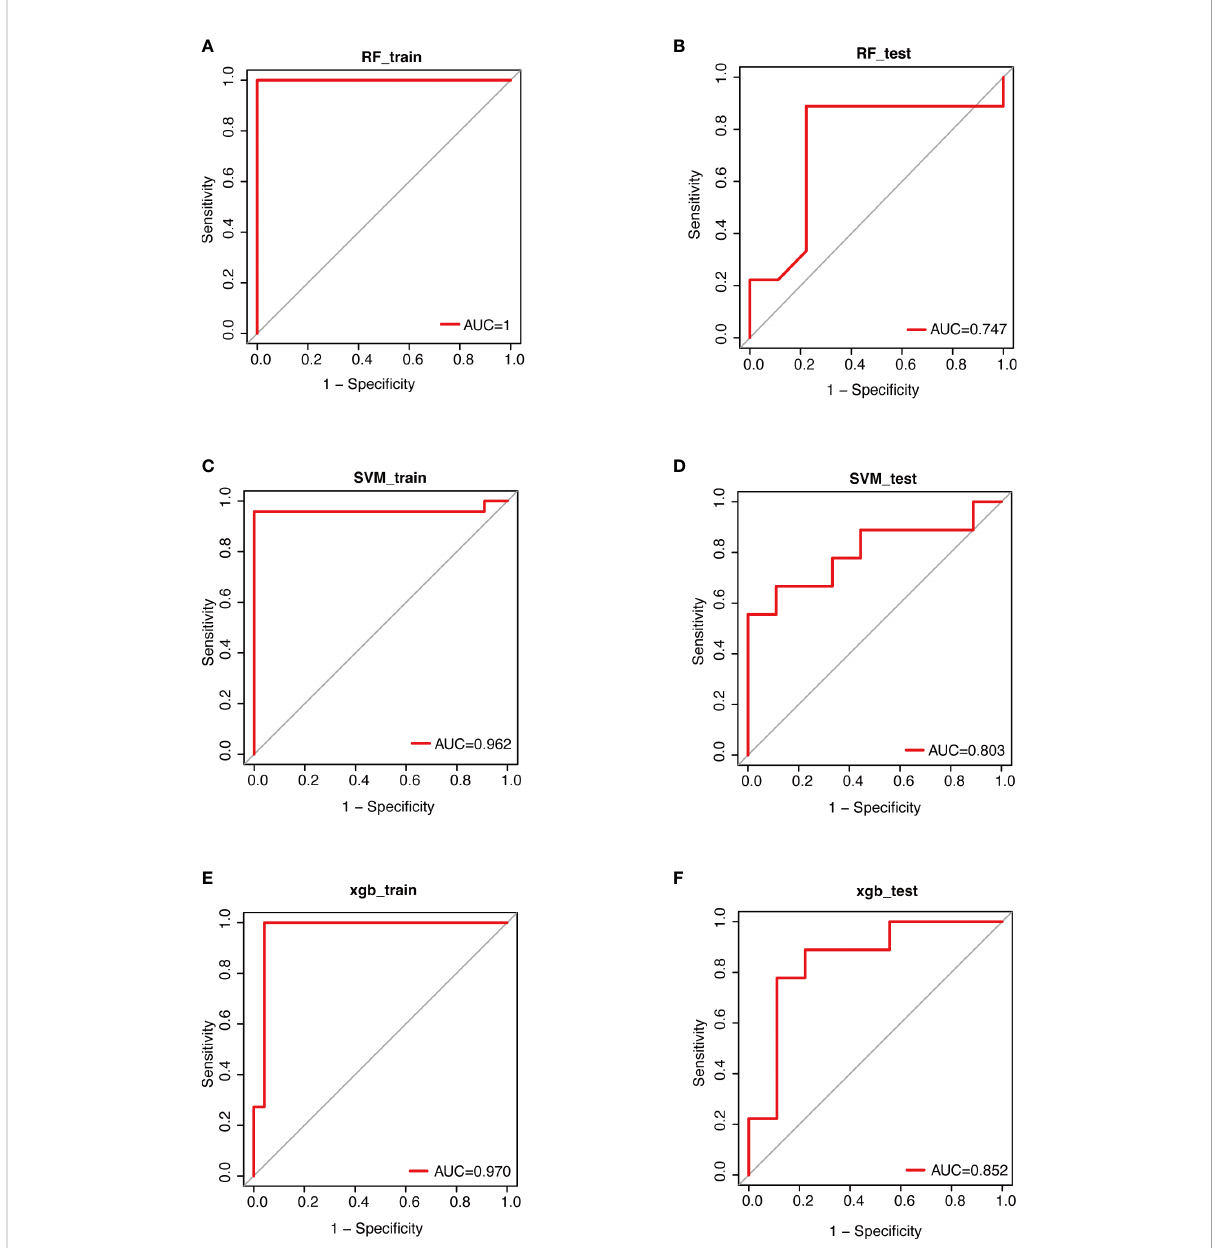
FIGURE 5 Performance evaluations of therapeutic effects based on 3 algorithms. Data were randomly divided into a training set and a testing set according to 7:3. ROC curves for evaluating the predictive performance of the therapeutic effect. (A) ; the training set of RF (B) ; the test set of RF (C) ; the training set of SVM (D) ; the testing set of SVM (E) ; the training set of XGBoost (F) ; the testing set of XGBoost. RF, Random Forest; SVM, Support Vector Machine; XGBoost, eXtreme Gradient